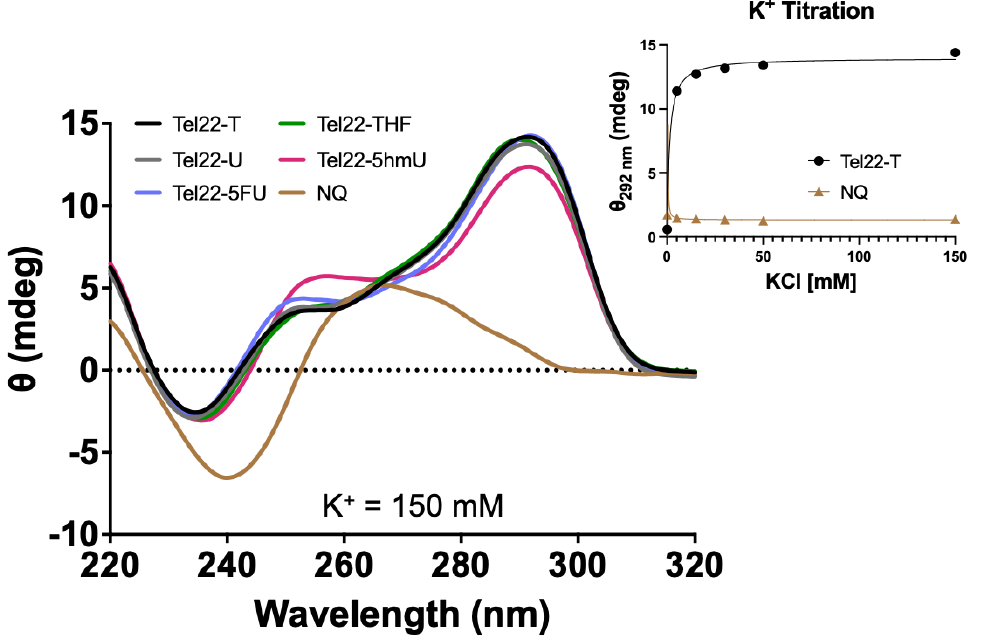
Figure 2. Pyrimidine analogs in the loop region did not disrupt G-quadruplex formation. CD spectra were acquired for quadruplex Tel22-X oligonucleotides or a non-quadruplex-forming (NQ) oligonucleotide. A 4 µ M solution was prepared in 20 mM Tris buffer, pH 7.4, 150 mM KCl, and 15 mM